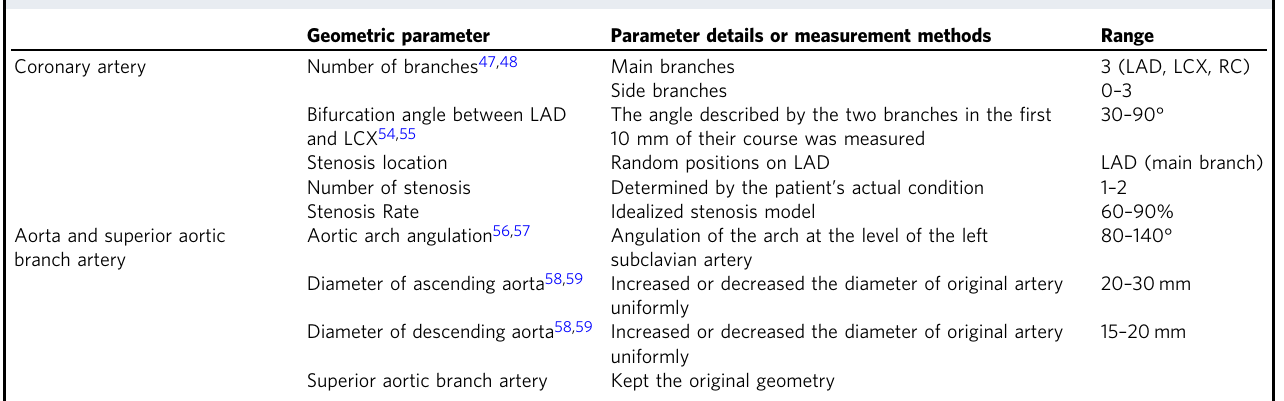
Table 3 Geometric parameters with corresponding